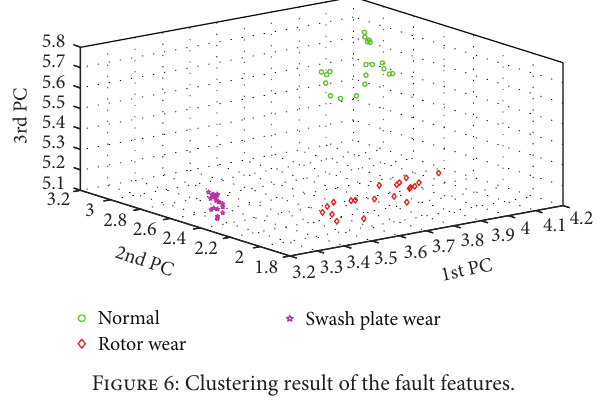
Figure 6: Clustering result of the fault features.